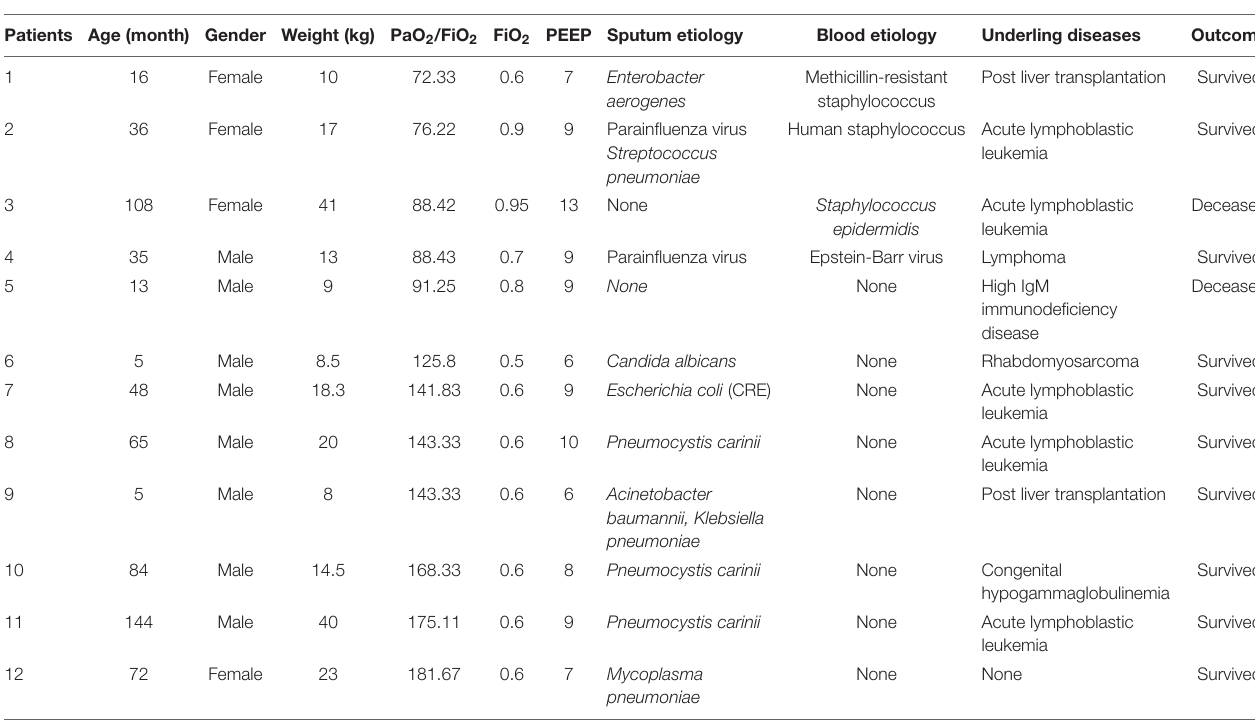
FIGURE 2 | Flowchart of patient enrollment in this study. HFOV, High frequency oscillation ventilation; ECMO, Extracorporeal membrane oxygenation. TABLE 1 | The clinical characteristics of 12 included children with Pards.